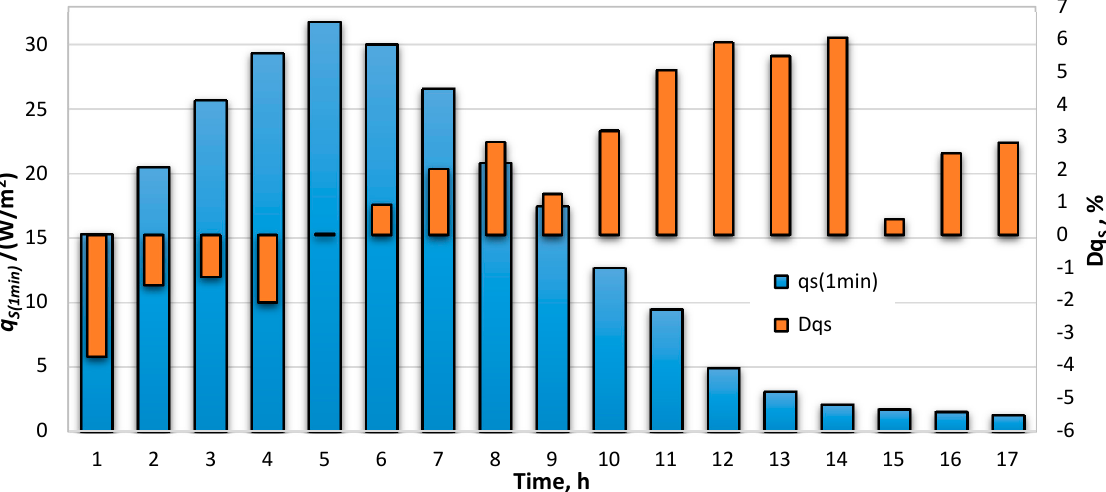
Figure 17. Heat loss calculated with a 1 min step and error resulting from the use of a 1 h time step— P 3 measurement series.